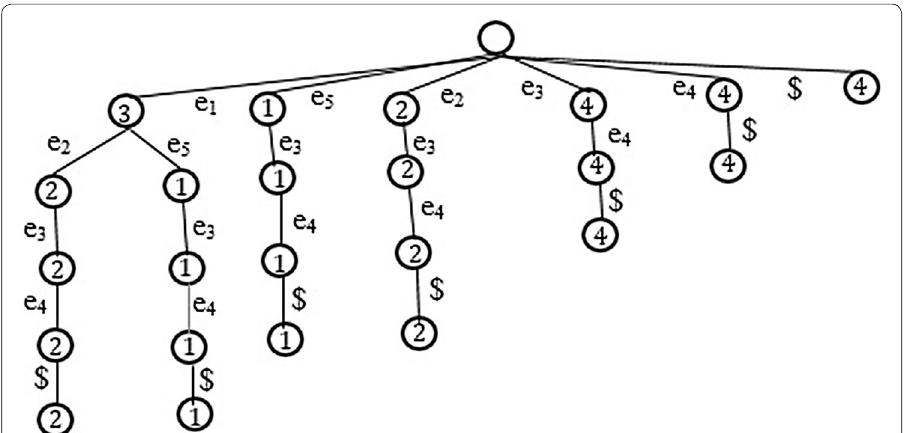
Fig. 6 PGST for string e1, e2, e5, e1, e3, e1, e4, e1, e2, e5, e1 with frequency count constructed by Algorithm